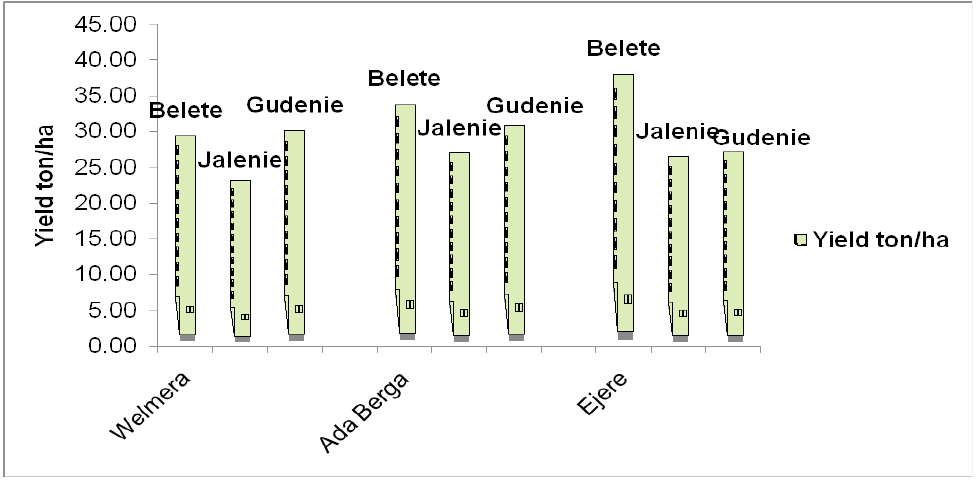
Figure 2: Performance of three released potato varieties in different